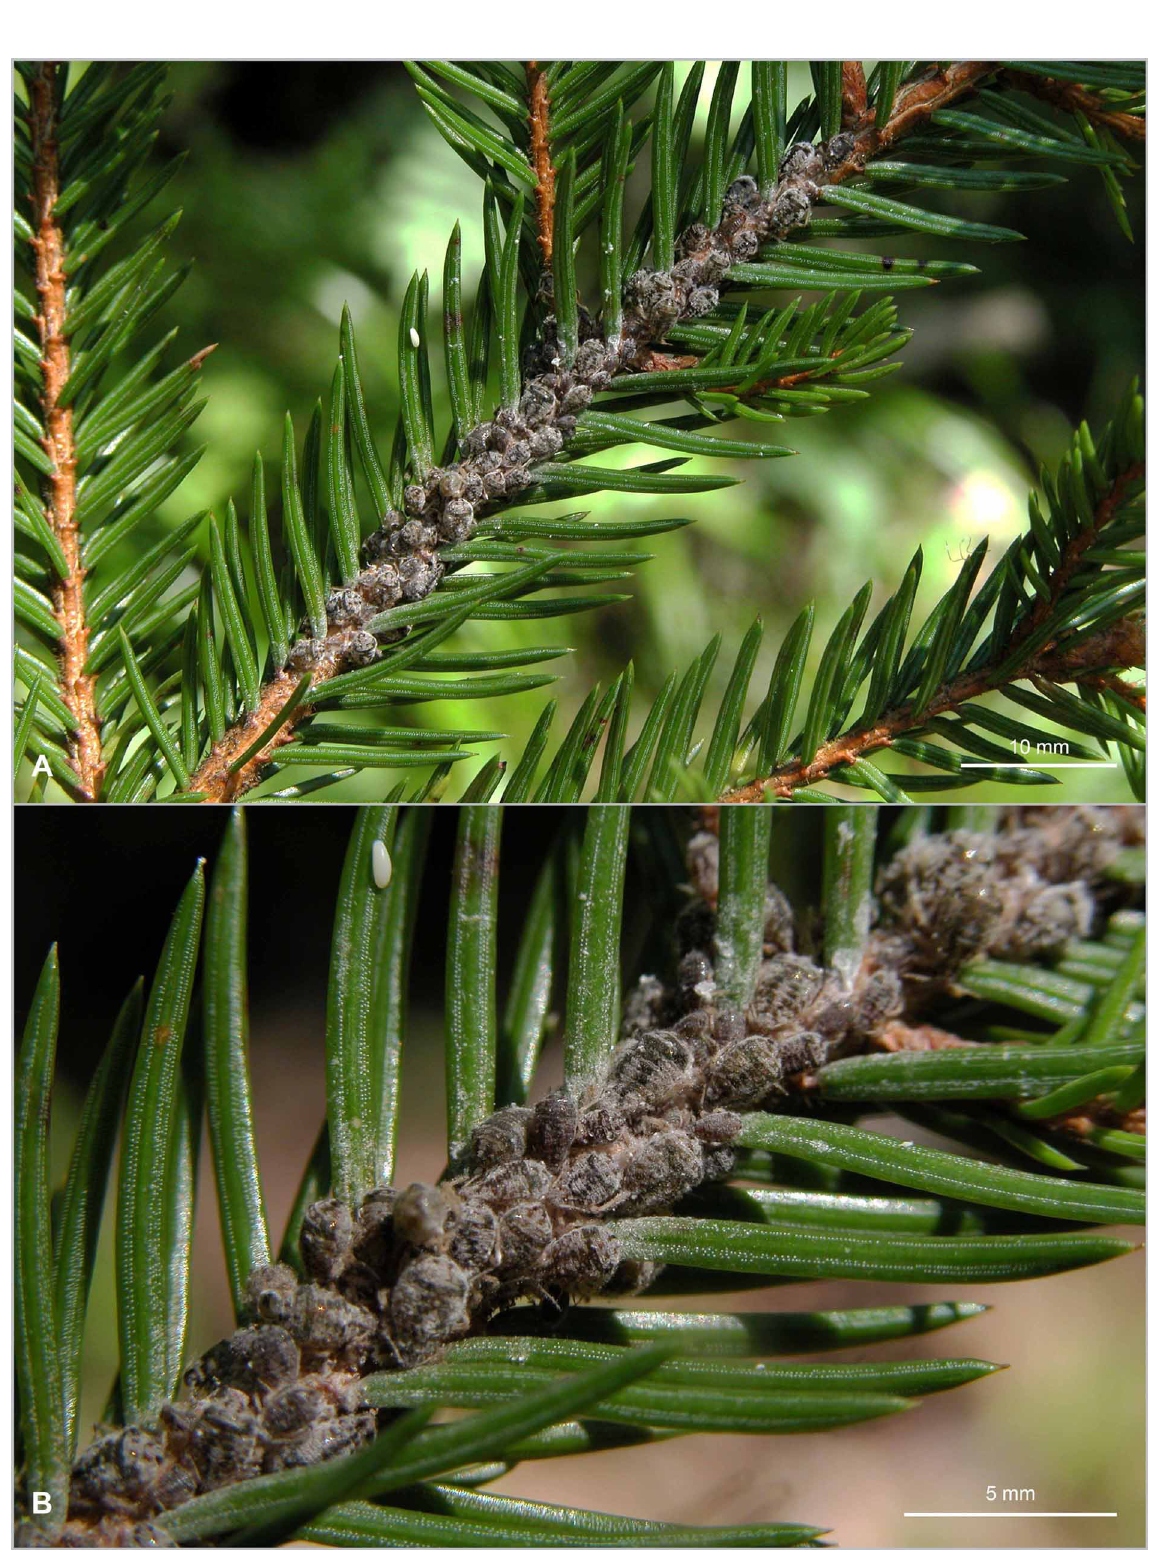
Fig. 32. Cinara (Cinara) costata (Zetterstedt, 1828). Colony on underside of a 1–2 year-old twig of Picea abies